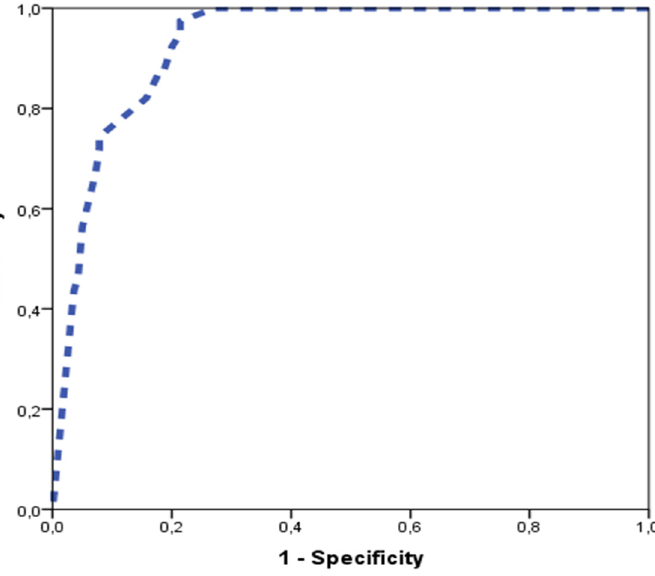
Figure 4. Receiver operating characteristics curve of the global multiparameter score prospectively applied (area under the curve (AUC), 0.93 (CI 95% 0.89–0.97)).